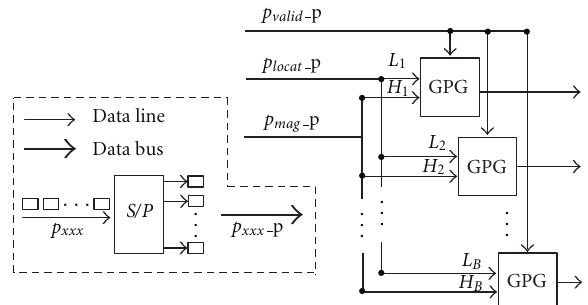
Figure 8: Serial-to-Parallel conversion (within the dashed line block) and parallel cancellation signals generation process. The symbol p xxx represents the signal p valid , p locat , and p mag , while p xxx p presents the corresponding parallel signals; L i is the initial value of an address generator for circular shift operation, while H i is used to scale the normalized cancellation unit.